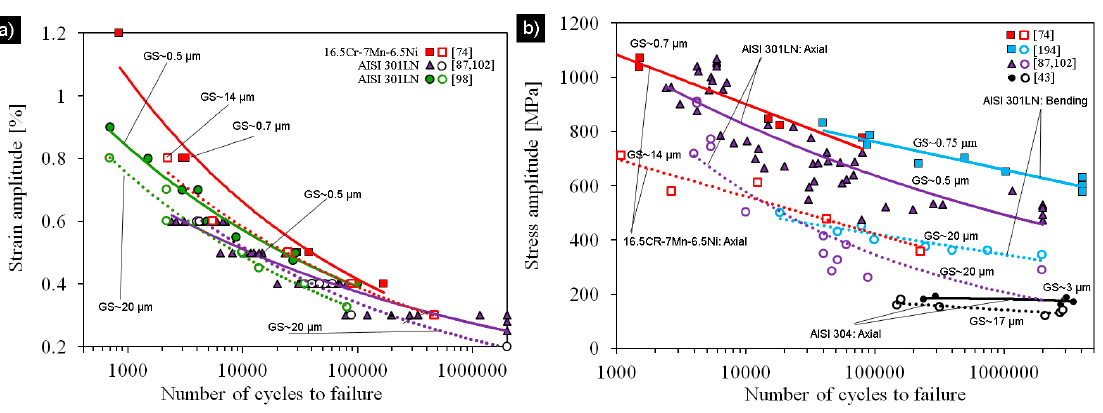
Figure 14. Fatigue life of reversion-treated 301LN in total strain-controlled tests compared to coarse-grained or annealed steel based on ( a ) strain amplitude and ( b ) mid-life stress amplitude. Data for 304 and 16.5Cr-7Mn-6.5N are from References [43] and [74], respectively.